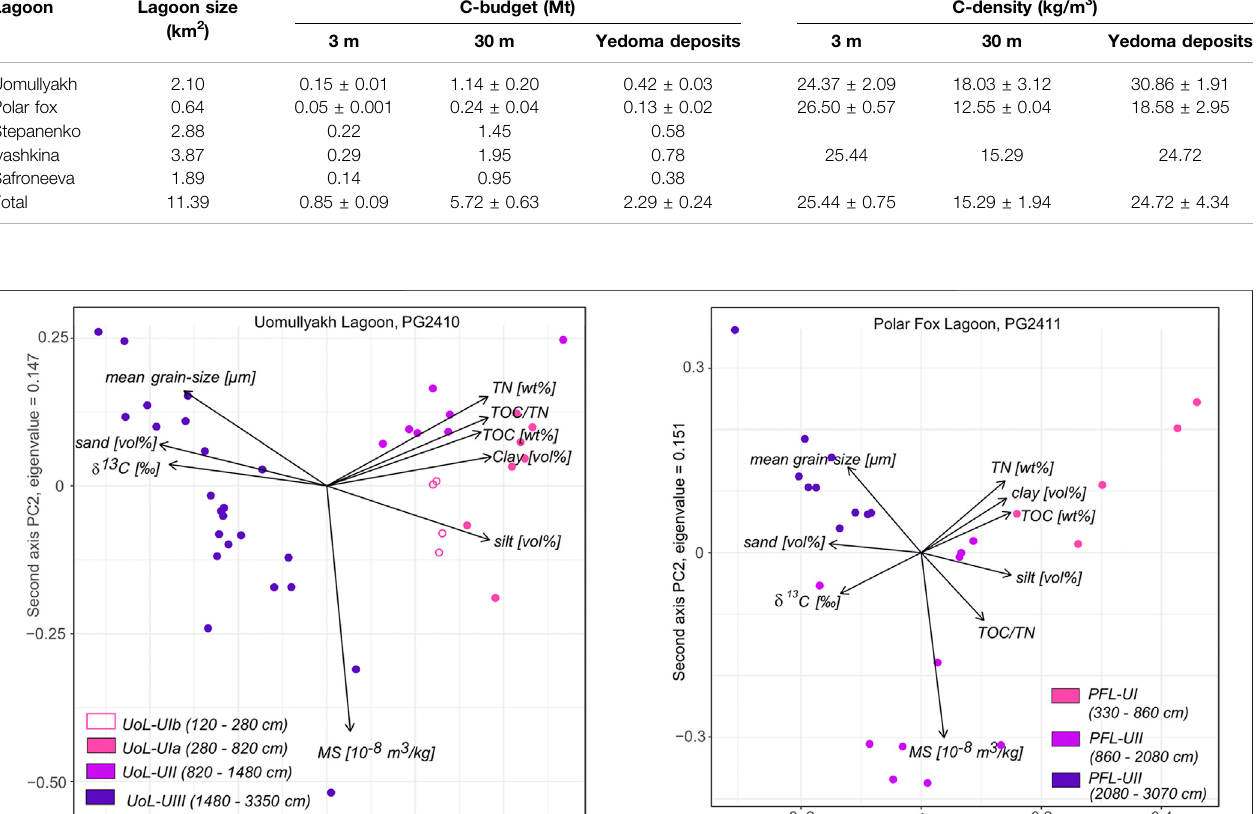
Frontiers in Earth Science |